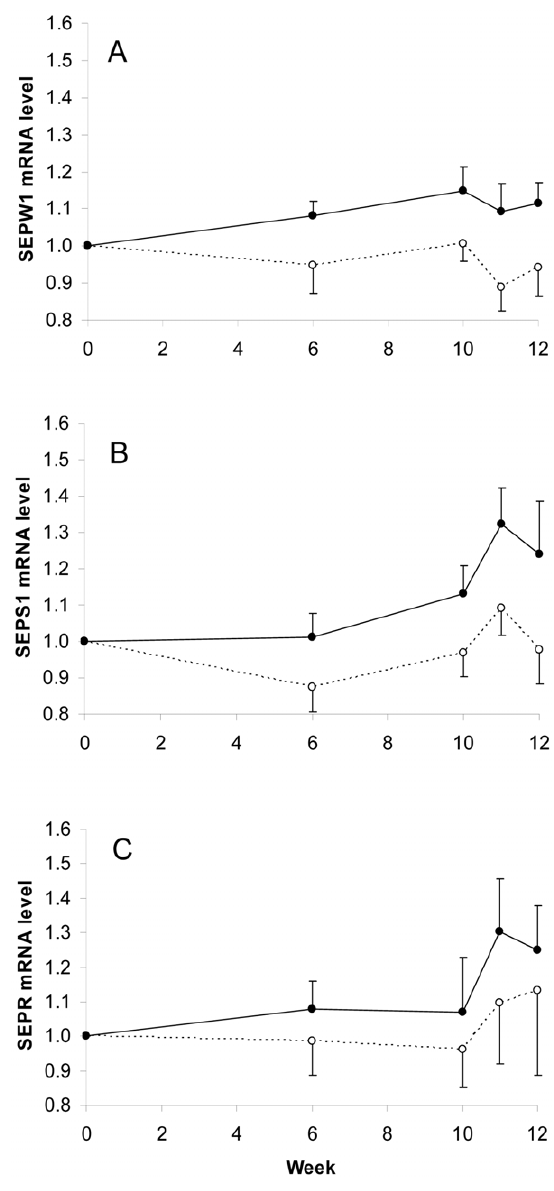
Figure 4. SEPW1, SEPS1 and SEPR mRNA level over the duration of the intervention in the PBMC samples from the unenriched and Se-enriched onion meal groups. SEPW1, SEPS1 and SEPR mRNA levels were quantified using real time RT-PCR and normalised to reference gene, GUSB. Data expressed are means 6 SEM relative to baseline, week 0 expression. (A) SEPW1, (B) SEPS1, (C) SEPR. N Values are means 6 SEM. --- # --- unenriched onions, n=14 to 16; — Se-enriched onions, n=16 to 17. SEPW1 mRNA level is — significantly greater in the enriched onion group compared to the unenriched onion group (p=0.012). SEPS1 mRNA level is significantly influenced by week (p=0.009).